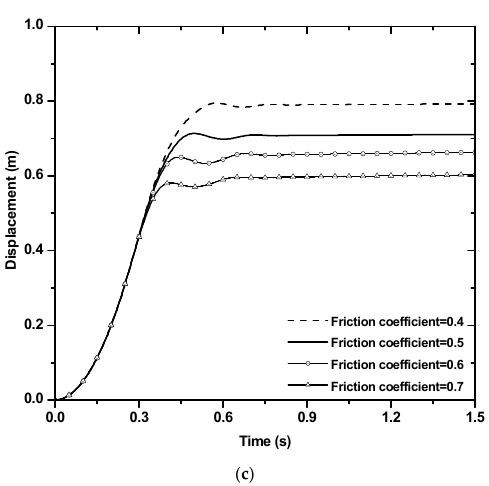
Figure 12. Vertical motion of weights clashing with gravel layers for different friction coefficients between the gravel pieces (friction coefficient between a gravel piece and the weight = 0.6): ( a ) acceleration; ( b ) velocity; ( c ) displacement.